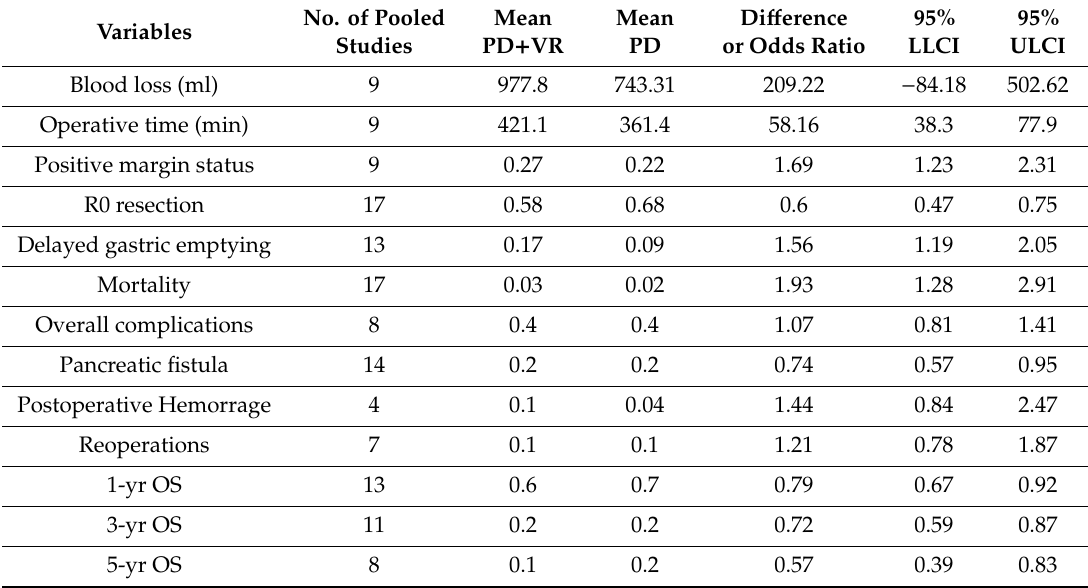
Table 2. Comparisons of postoperative outcomes and survival outcomes. LLCI: Lower Level Confidence Interval; ULCI: Upper Level Confidence Interval.